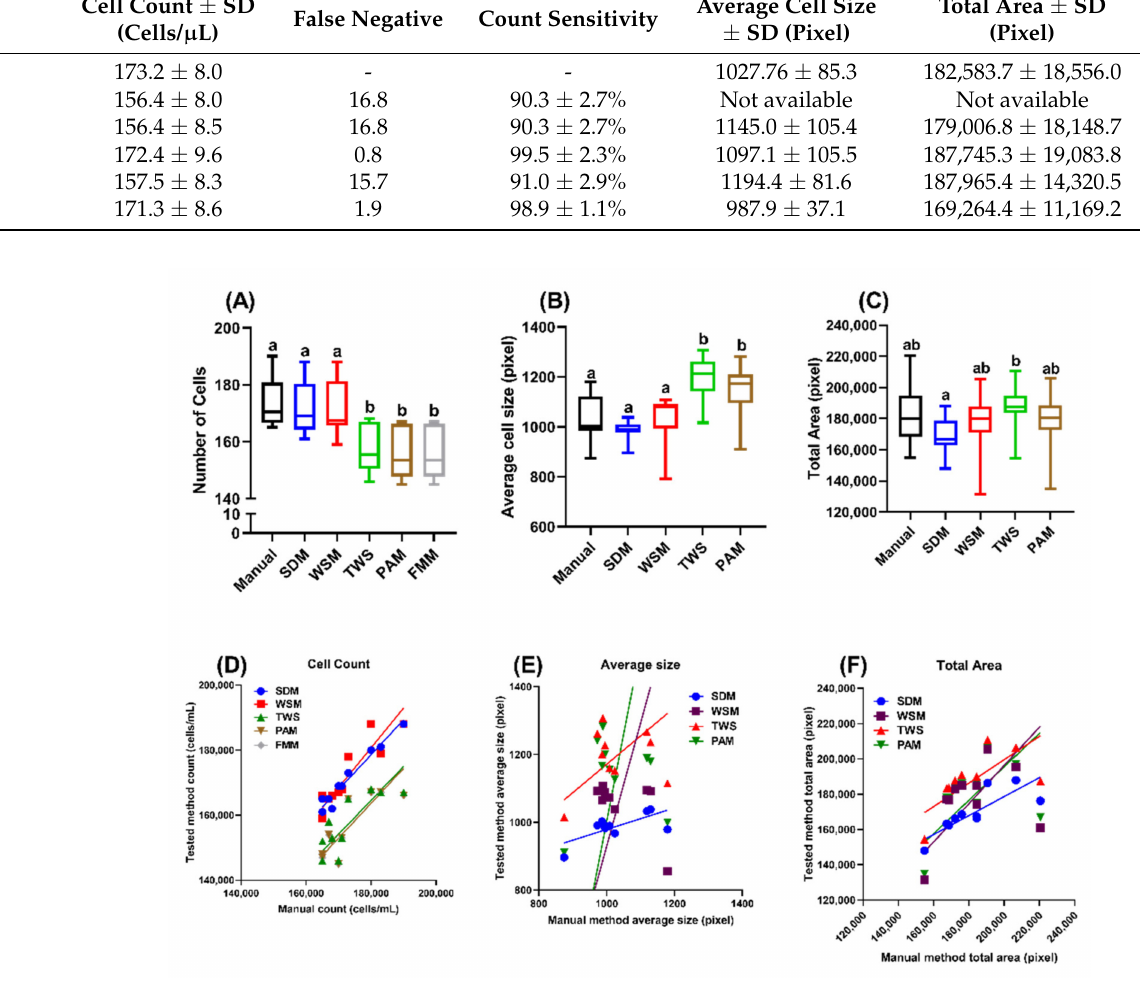
Figure 2. Assessment of the consistency and performance of five Tetrahymena counting methods. Comparison of the cell count ( A ), average cell size ( B ) and total area occupancy ( C ) result of Tetrahy- mena using five different methods for manual counting and measurement using one-way ANOVA. Different letter represents statistical difference ( p < 0.05). Deming regression of the results obtained from five methods for manual counting and measurement of Tetrahymena cell count ( D ), average size ( E ) and total area ( F ). For each method, data obtained from ten image captures were used for